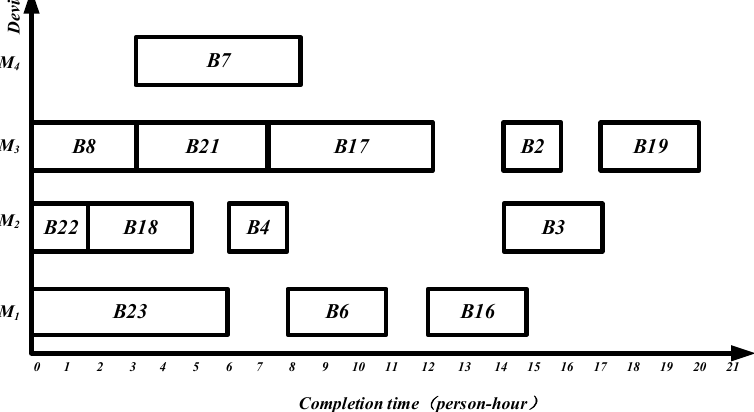
Electronics 2023 , 12 , x FOR PEER REVIEW Figure 20. Gantt chart obtained by the ACPM for workshop f 2 with 20 person-hours. Figure 20. Gantt chart obtained by the ACPM for workshop f Figure 20. Gantt chart obtained by the ACPM for workshop f